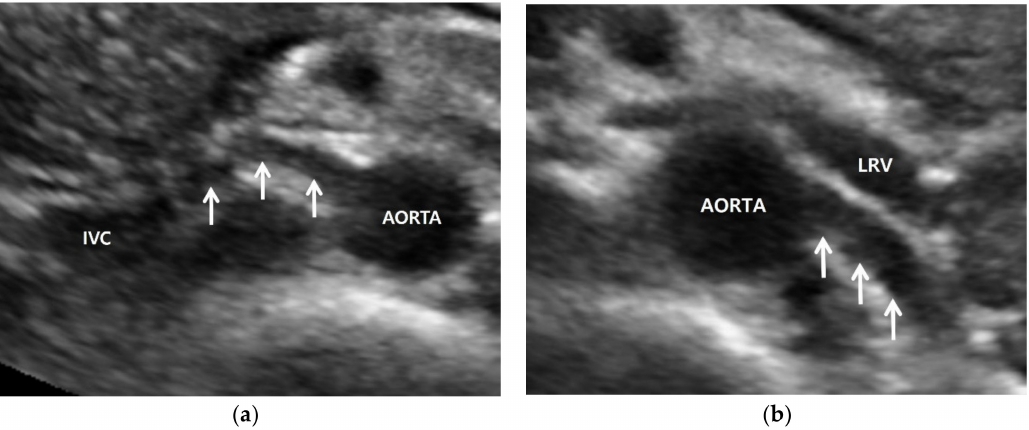
Figure 1. Normal anatomy of renal artery. ( a ) Gray-scale US axial image shows right renal artery (arrows) arising 10 o’clock from the aorta. It shows a short segmental angulation behind the inferior vena cava (IVC); ( b ) gray-scale US axial image shows left renal artery arising 4 o’clock from the aorta. It is located below the left renal vein (LRV) and is traveling away from the transducer without